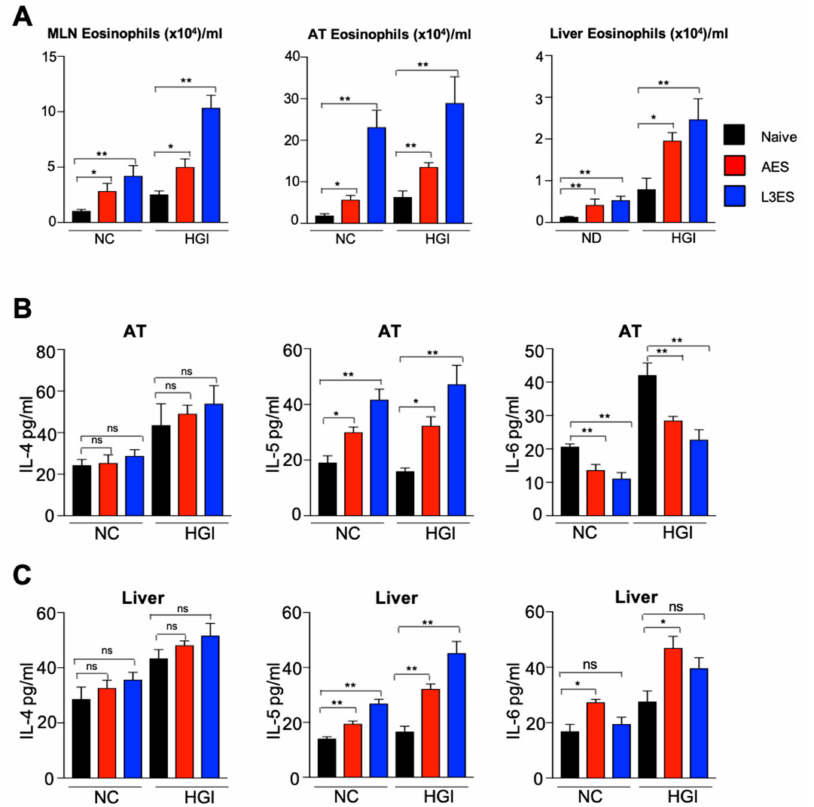
Figure 3. Increase in the frequency of eosinophils in the mesenteric lymph nodes (MLN), adipose tissue (AT), and liver in mice fed a normal control (NC) or high glycaemic index (HGI) diet and treated with excretory/secretory (ES) products from Nippostrongylus brasiliensis third-stage larvae (L3ES) or adult worms (AES): ( A ) Eosinophil frequency and total numbers in mLNs, AT, and liver; ( B ) AT IL-4, IL-5 and IL-6 expression; ( C ) Liver IL-4, IL-5, and IL-6 expression. Statistical significance was determined with Student’s t -text. Data are expressed as means ± SEM from 2 pooled experiments where n = 5/group for each experiment. * p < 0.05; ** p < 0.01. ns = not significant, p >